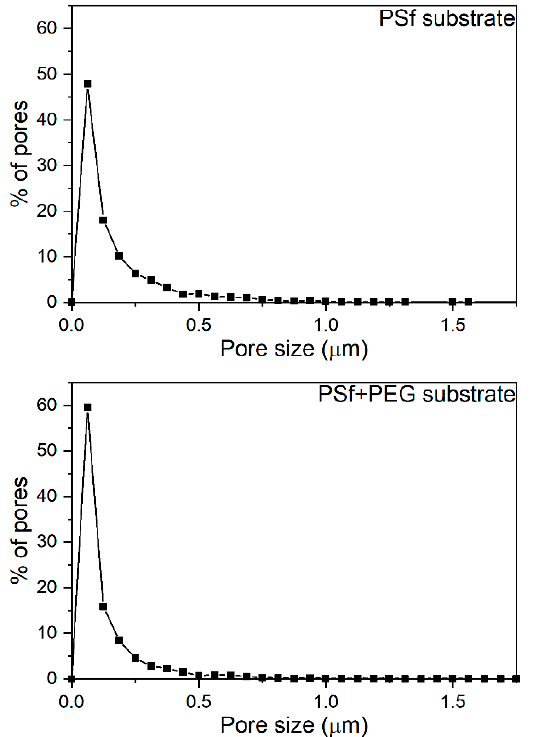
Figure 9. The pore size distribution of PSf and PSf+PEG substrate using ImageJ program.